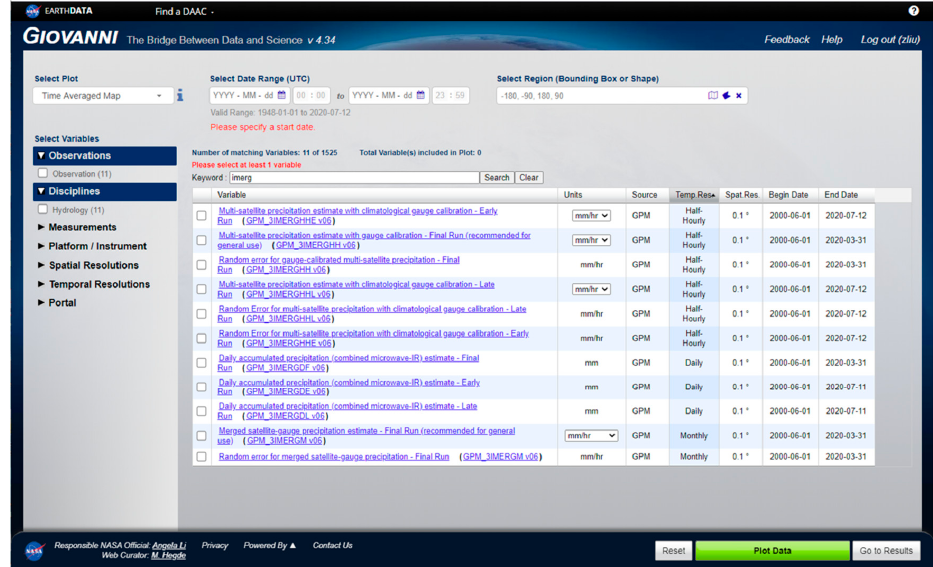
Figure 2. The landing page of Giovanni, developed by GES DISC to facilitate data analysis and visualization without downloading data and software. A keyword search box is provided for searching over 1500 variables for the time being and more variables to be added. As the cloud version of Giovanni is being developed, better performance and more data from other Distributed Active Archive Centers (DAAC) will be expected.